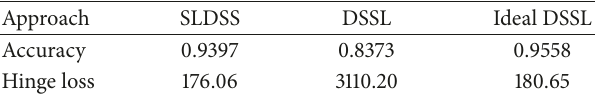
Table 1: Performance on synthetic data as measured by correctly ordered pairs, accuracy, and by aggregated error (magnitude of difference in wrongly ordered pairs), Hinge